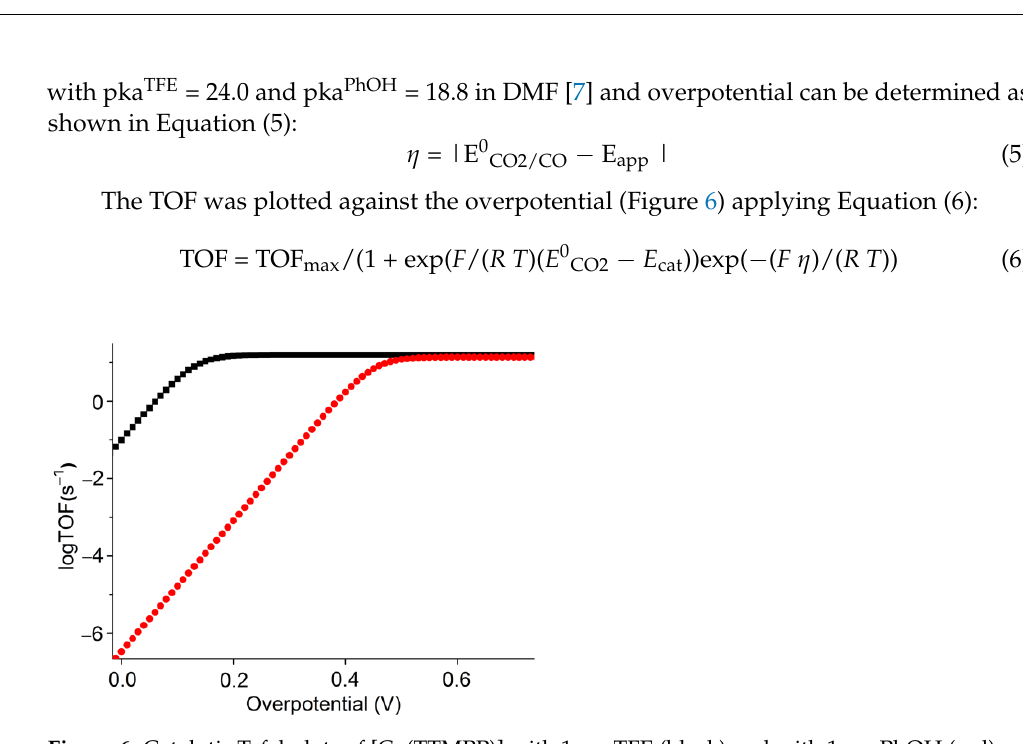
Figure 6. Catalytic Tafel plots of [Co(TTMPP)] with 1 eq. TFE (black) and with 1 eq. PhOH (red).